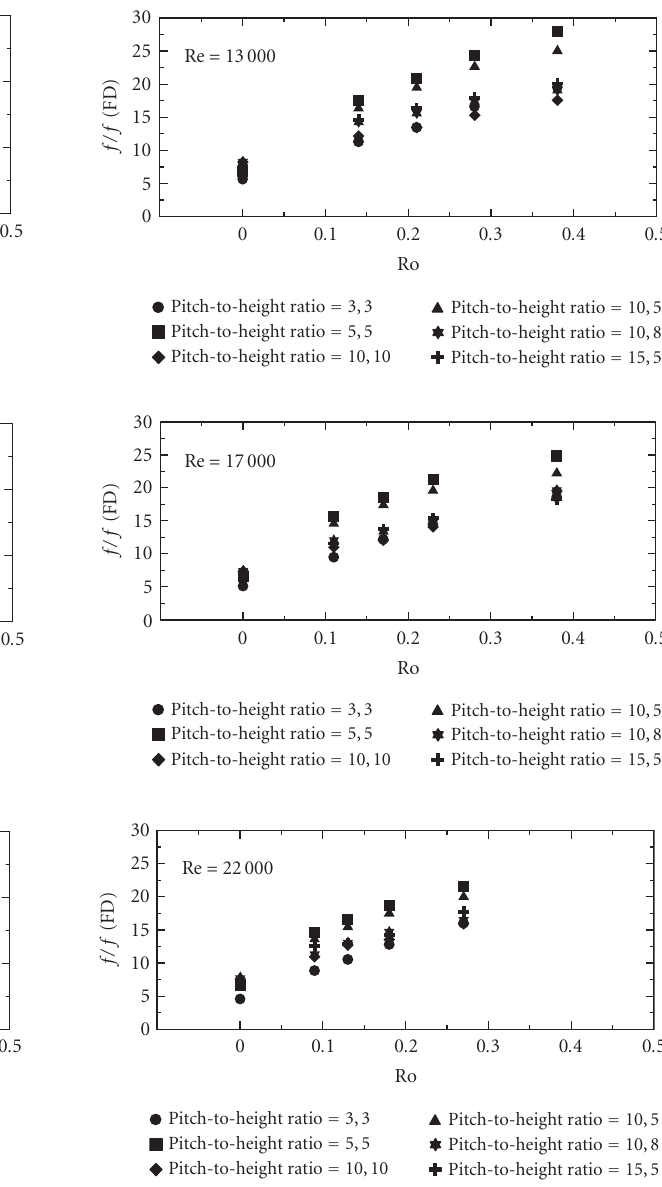
Figure 9: E ff ect of the orientation angle for 90 ◦ ribbed radial out- ward flow channel for a rib pitch-to-height ratio of 15,5.